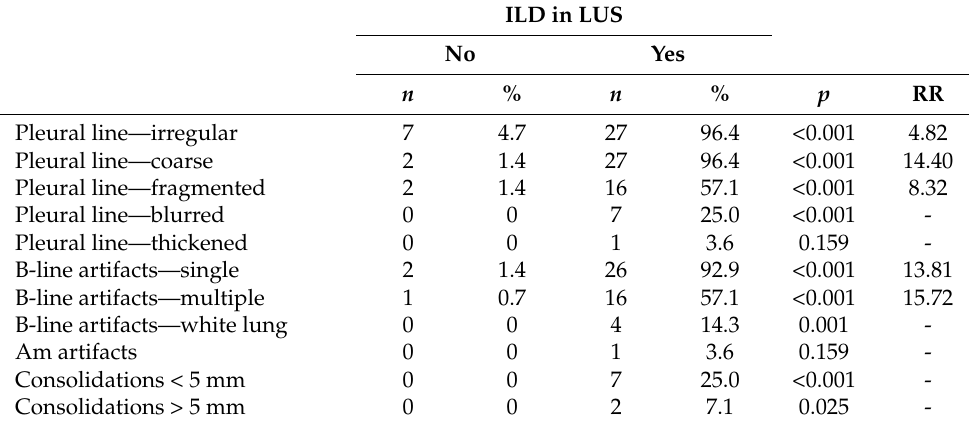
Table 6. Analysis of the frequency of findings detected in